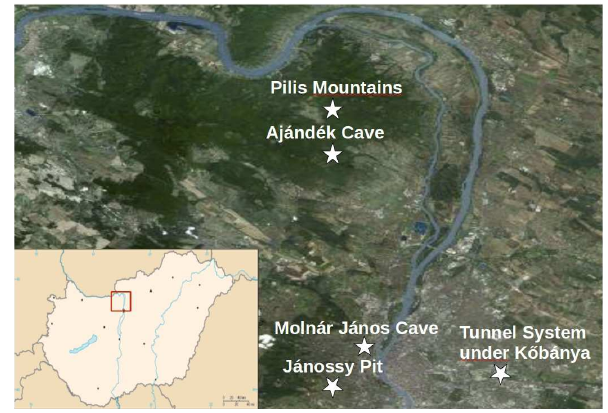
Fig. 3. Test measurements have been taken in Hungary with the REGARD muon tomograph.